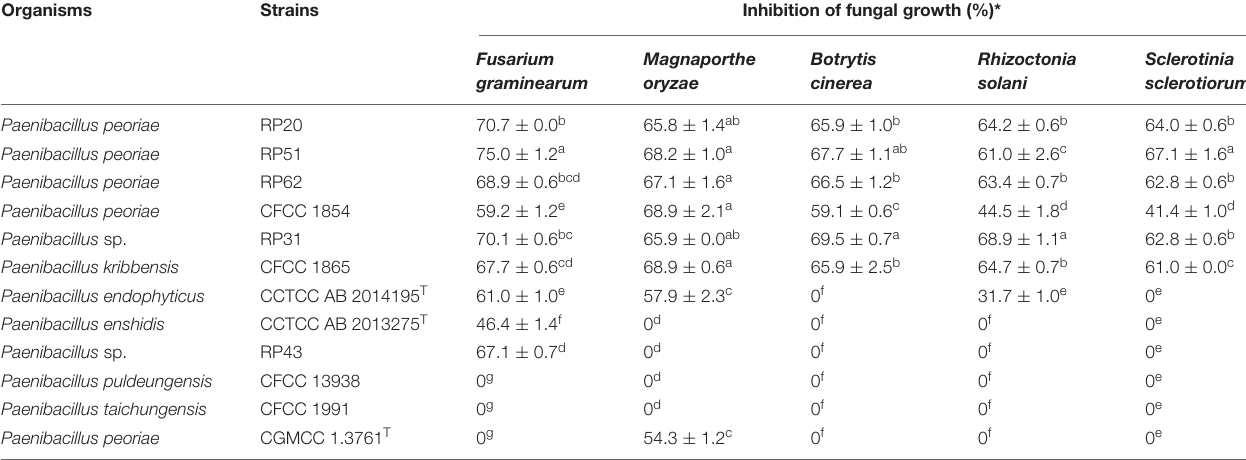
TABLE 2 | Inhibition of fungal growth by Paenibacillus